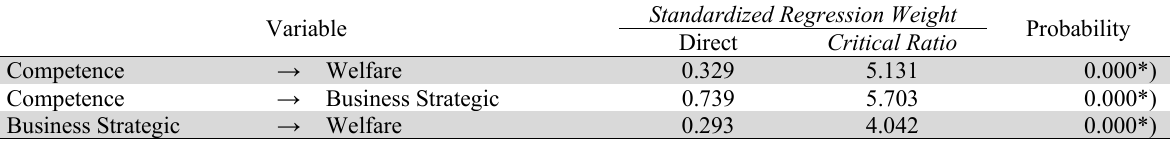
Standardized Regression